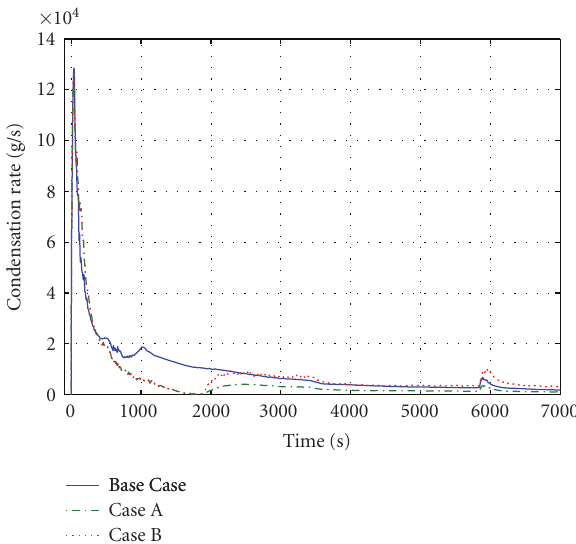
Figure 7: Total condensation rate on structure surfaces.